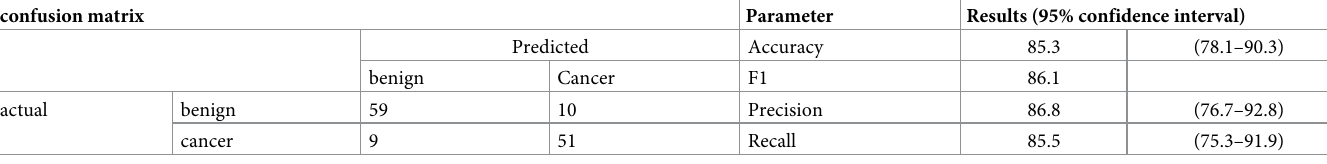
Table 2. Performance of supervised neural network analysis for classifying samples as benign or cancerous based on DAB expression only. confusion